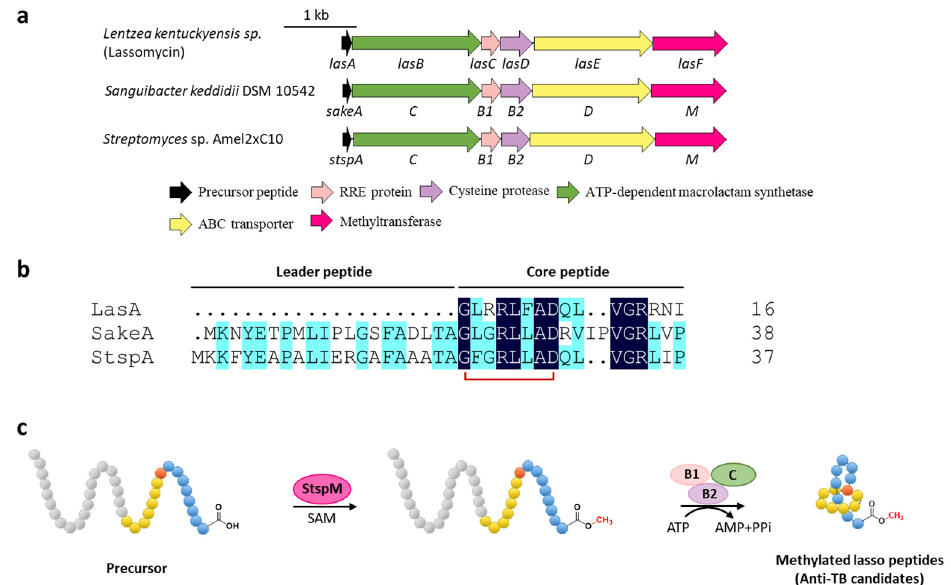
Figure 4. C-terminal methylation of lassomycin and related lasso peptides. ( a ) The BGCs of methylated lasso peptides. ( b ) Sequence alignment of precursor peptides. ( c ) Proposed biosynthetic pathway of C-terminal methylated lasso peptides. StspM methylates the C-terminal carboxyl group of precursor peptide.